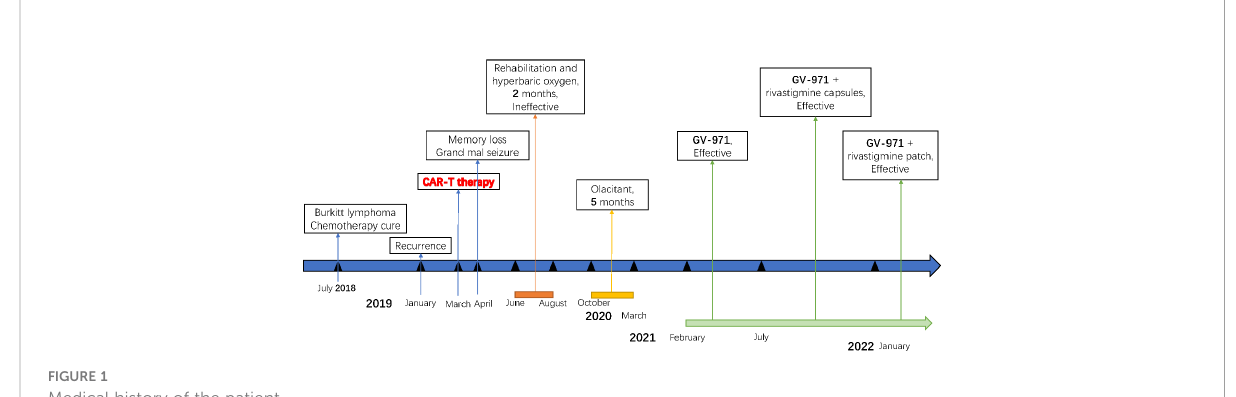
FIGURE 1 Medical history of the